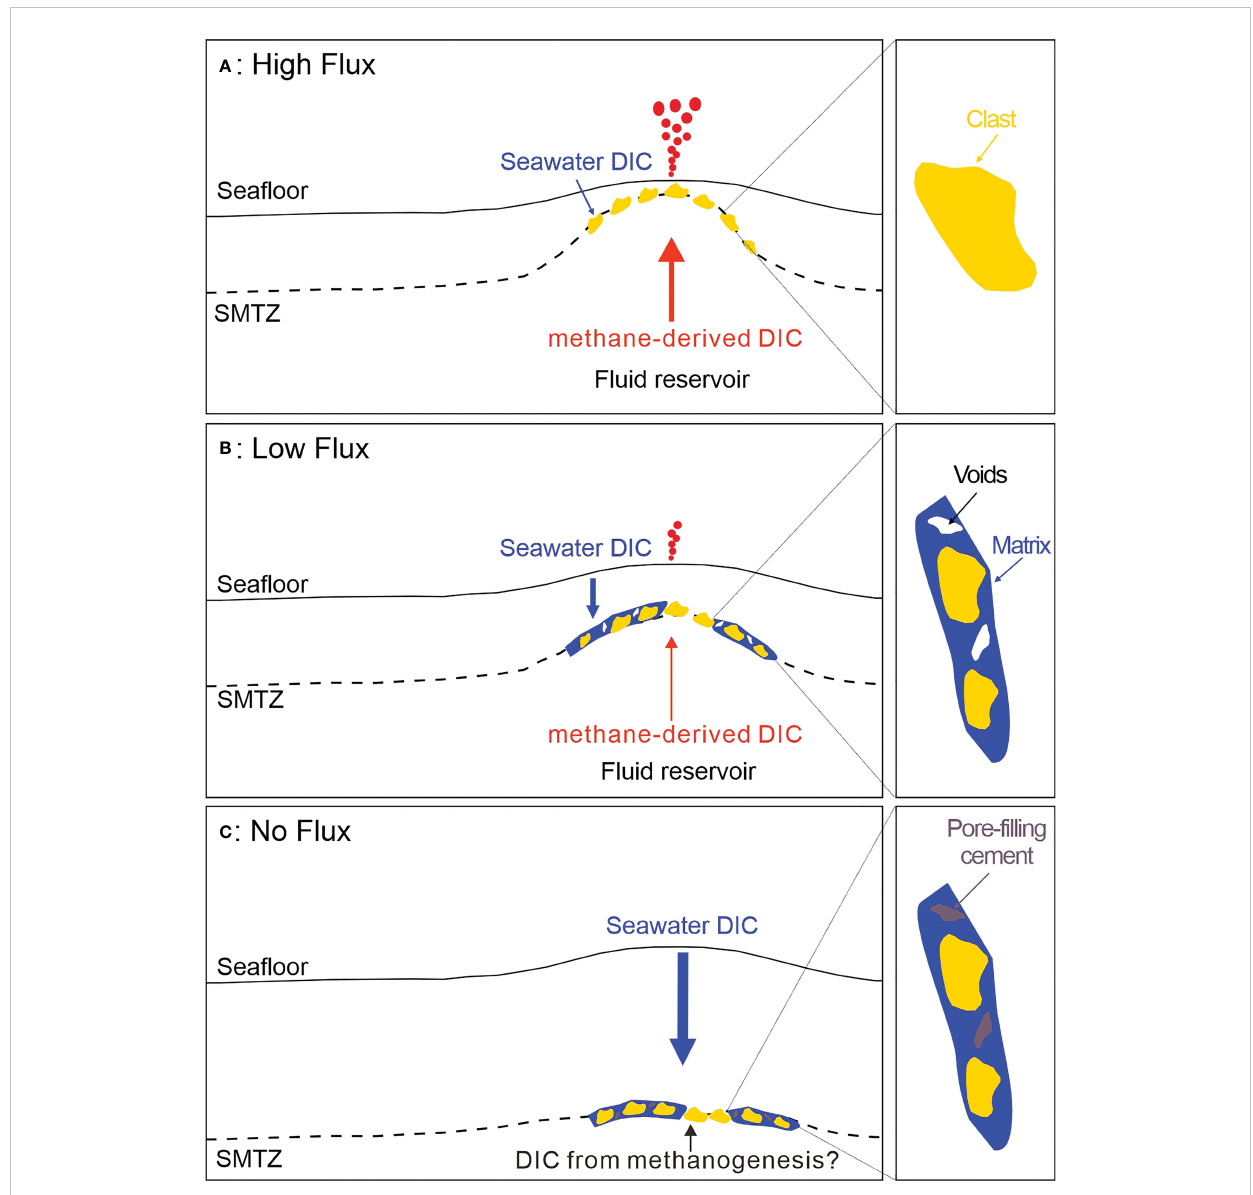
FIGURE 4 Schematic model illustrating the evolution of seep fl uids and formed components of the seep carbonate (after Feng et al., 2009 and Bian et al., 2013). (A) High fl ux of the fl uid seepage led to precipitation of clasts in subsurface sediment; (B) The clasts were being cemented together by a surrounding matrix sediment during the decrease of fl uid fl ux. (C) Pore- fi lling cements tend to occur then the fl uid fl ux diseased. Meantime, seawater was transported downwards from a minor mode to moderate mode. SMTZ, sulfate methane transition zone. The arrow sizes are proportional to the upward methane fl uxes and downward seawater fl